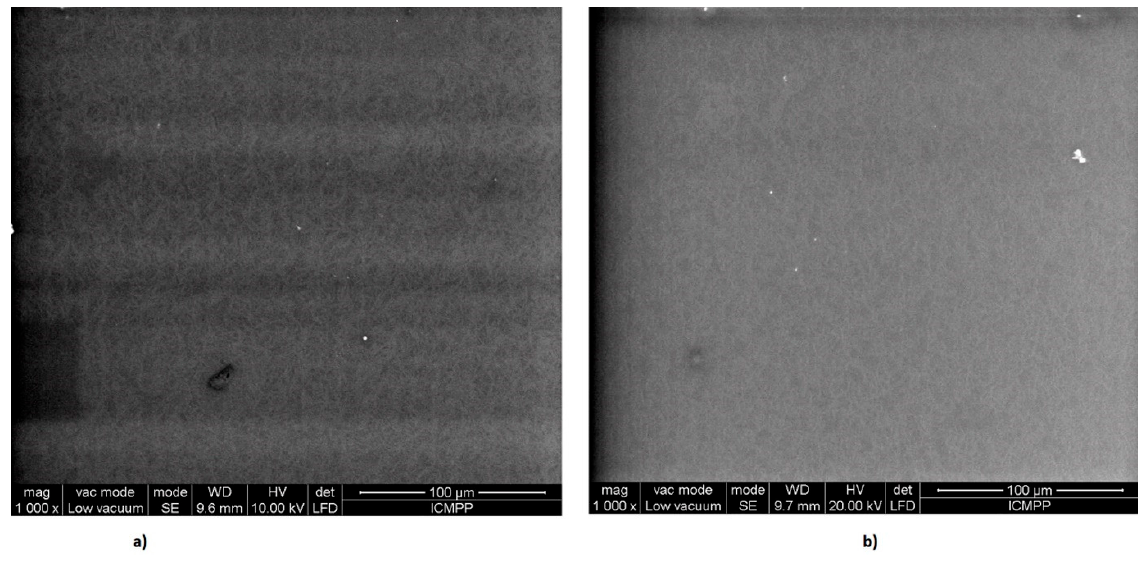
Figure 4. SEM images of PVA foils obtained ( a ) before and ( b ) after 180 s of MW irradiation of aqueous solutions.